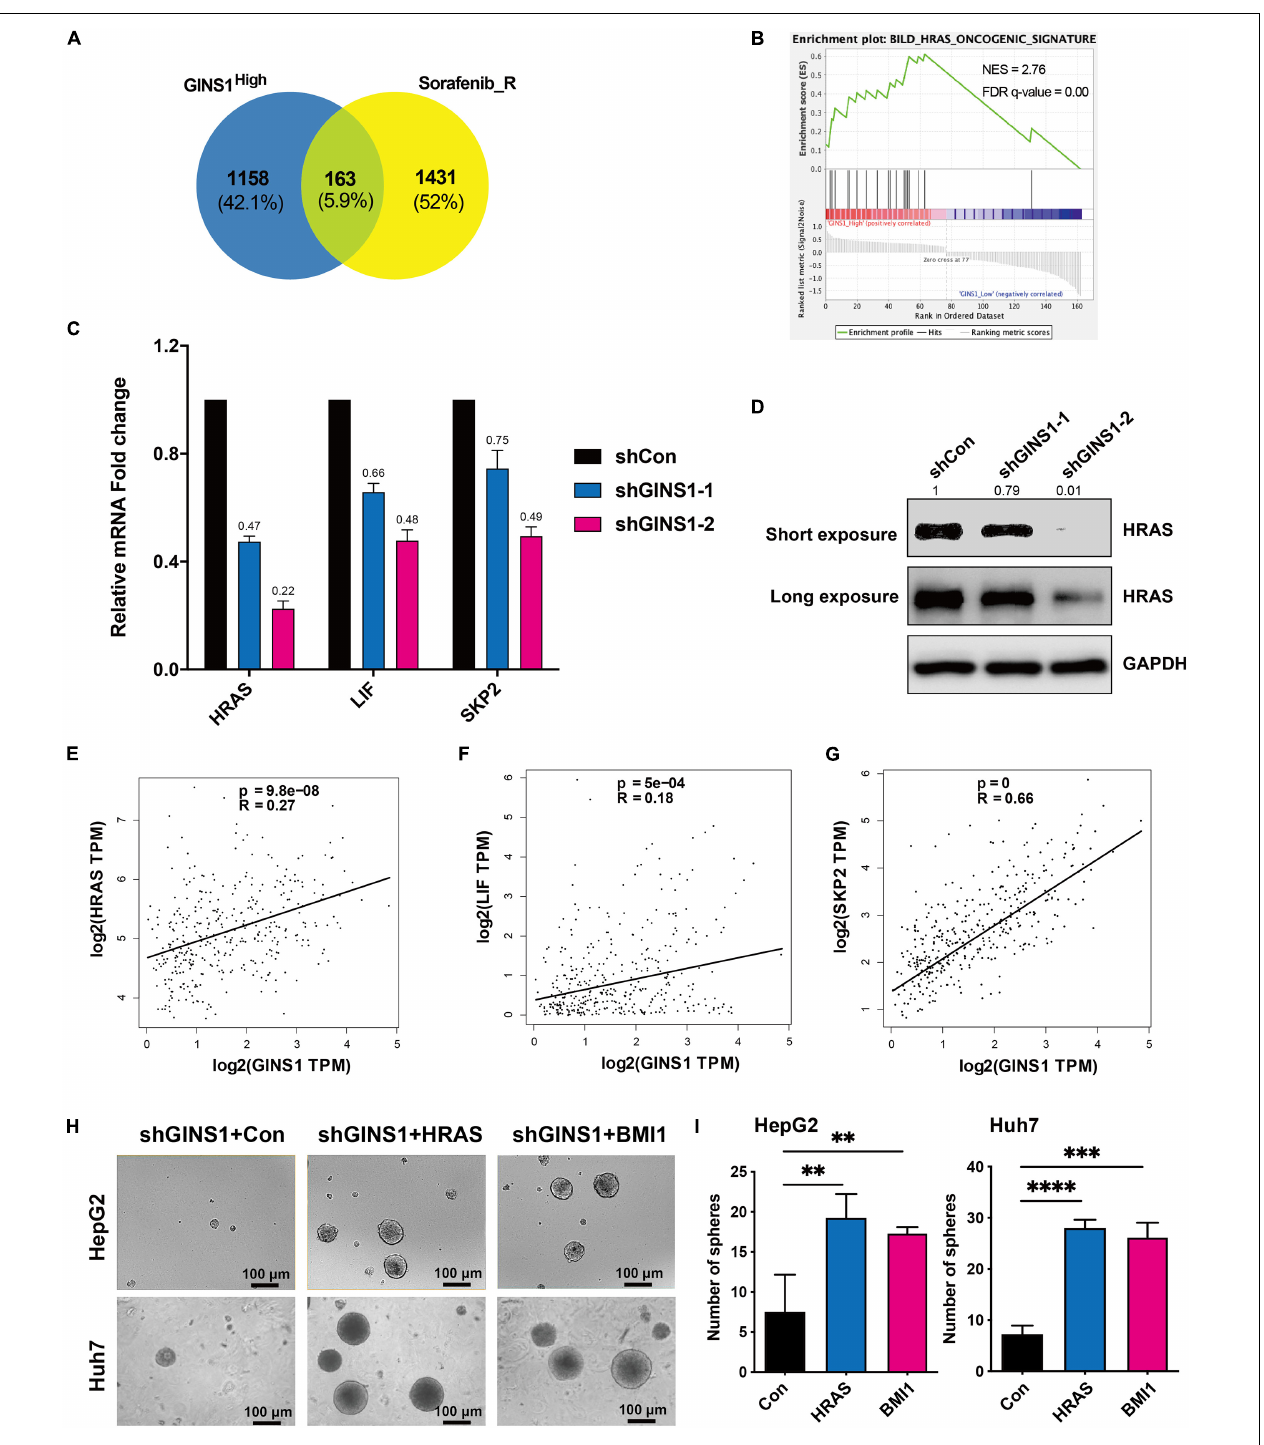
FIGURE 4 | GINS1 mediated CSCs by activating the HRAS pathway. (A) Venn diagrams of overlapped genes in GINS1 regulation (from GSE17112) and expressed genes in response to sorafenib resistance (from GSE143233). (B) GSEA of the overlapped genes in (A) revealed HRAS pathway associated with CSCs. (C) transcription levels of HRAS pathway related molecules in Huh7 shGINS1 and shCon cells were determined by RT-qPCR. (D) protein expressions of GINS1 and HRAS in Huh7 shGINS1 and shCon cells were determined by immunoblot, and the expression ratio was counted. (E–G) correlation of HRAS pathway related molecules [HRAS (E) , LIF (F) , and SKP2 (G) ] and GINS1 expression present within TCGA database. Data are presented as mean ± SD. (H,I) images of the sphere of HepG2 shGINS1 and Huh7 shGINS1 cells rescued with HRAS or BMI1 overexpression (H) and the number of sphere formation was quantified (I ; mean ± SD). Scale bar represents 100 µ m. Data are presented as mean ± SD. ∗∗ P < 0.01; ∗∗∗ P < 0.001; and ∗∗∗∗ P < 0.0001.